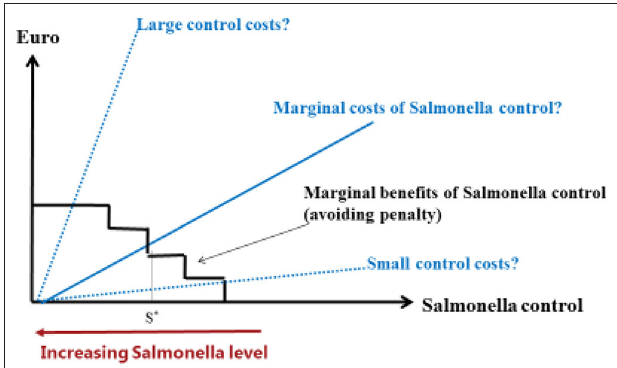
FIGURE 1 | Illustration of optimal Salmonella control problem with uncertainty about costs of Salmonella